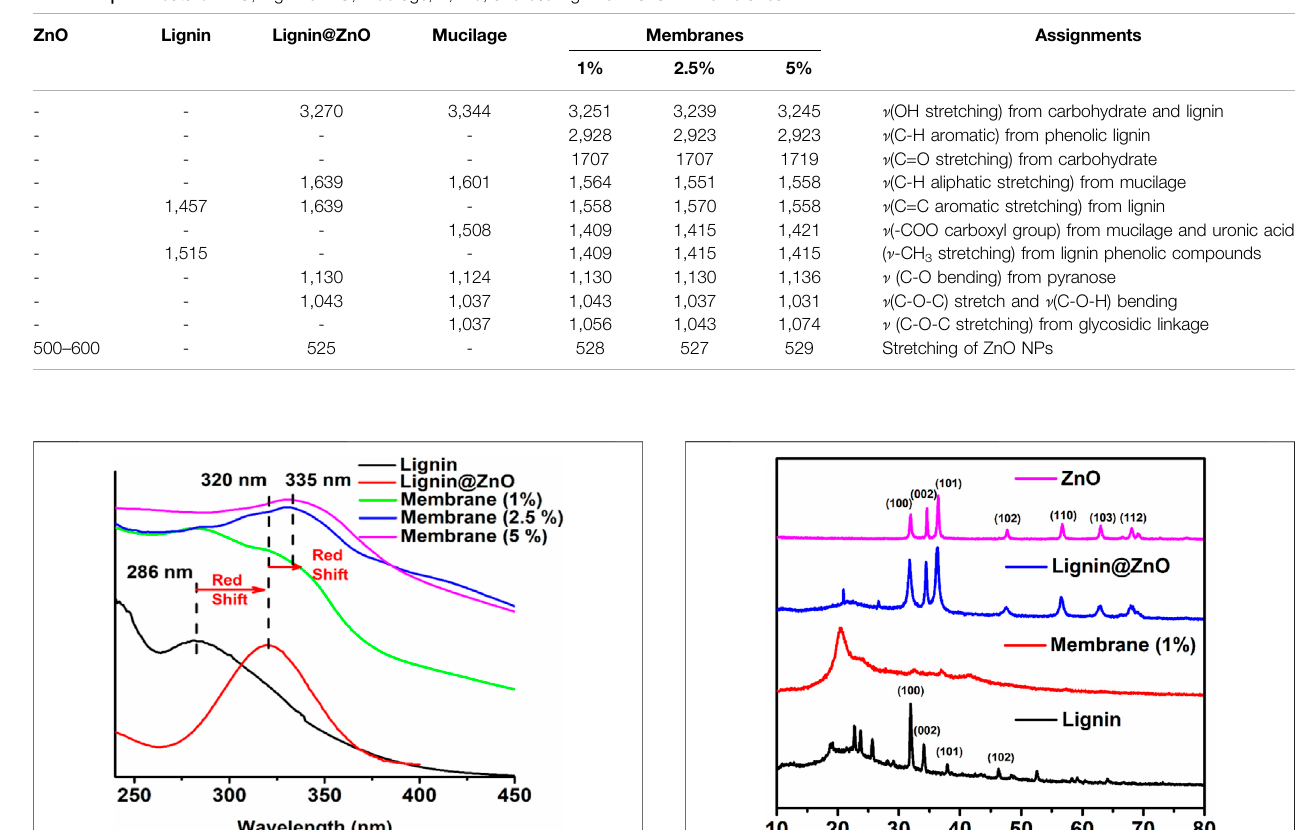
TABLE 1 | FTIR data of ZnO, Lignin@ZnO, mucilage, 1, 2.5, and 5% Lignin@ZnO-GTR membranes.